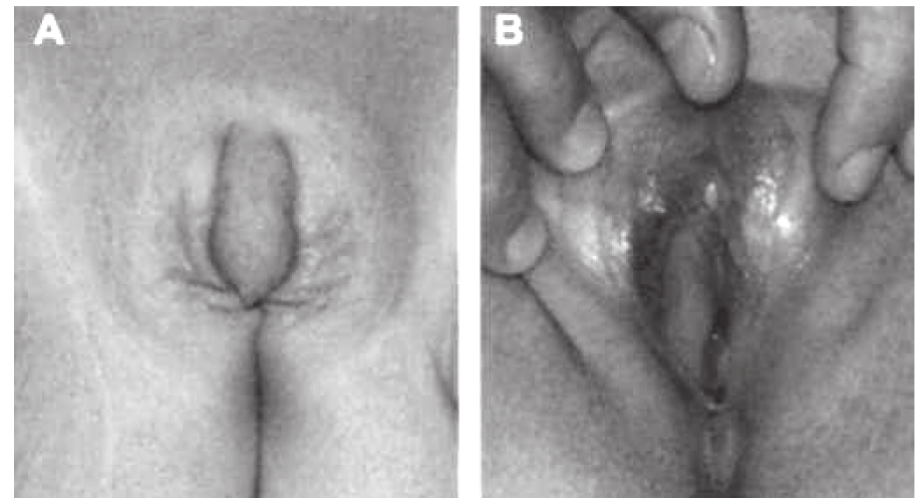
Figure 1 - External genitalia of patient with congenital adrenal hyperplasia before (A) and after (B) genitoplasty - cosmetic result classified as